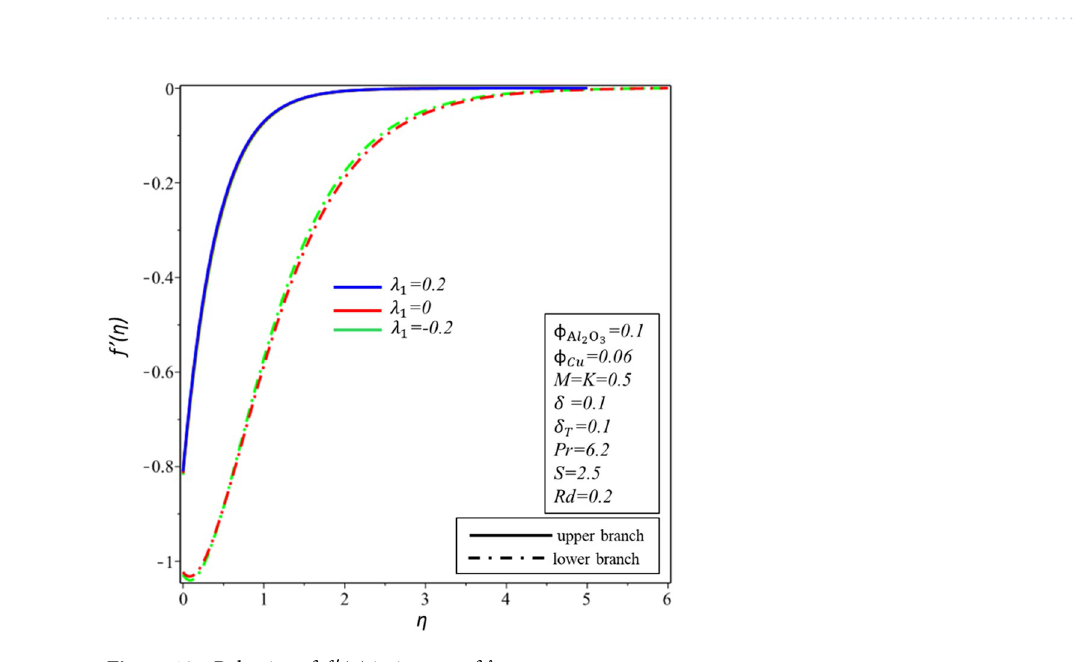
Figure 11. Behavior of θ(η) in impact of Rd .